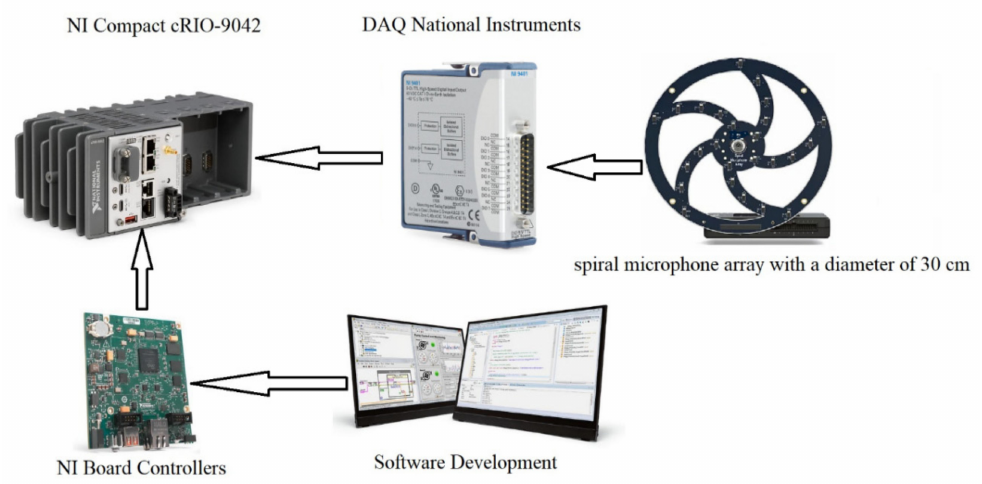
Figure 1. Proposed System’s Hardware Architecture.